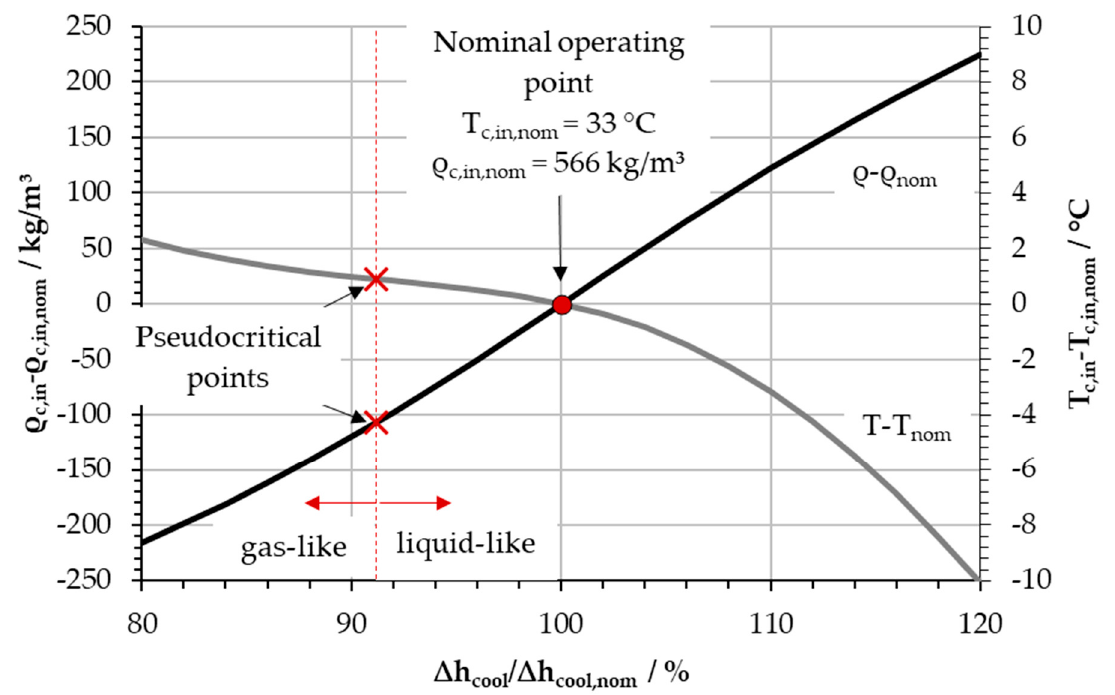
Figure 5. Change of the sCO2-HeRo compressor inlet density and static temperature with cooling power at constant pressure of p c,in,nom = p cool,in,nom = 78.3 bar and cooler inlet temperature of T cool,in,nom = 167 °C.